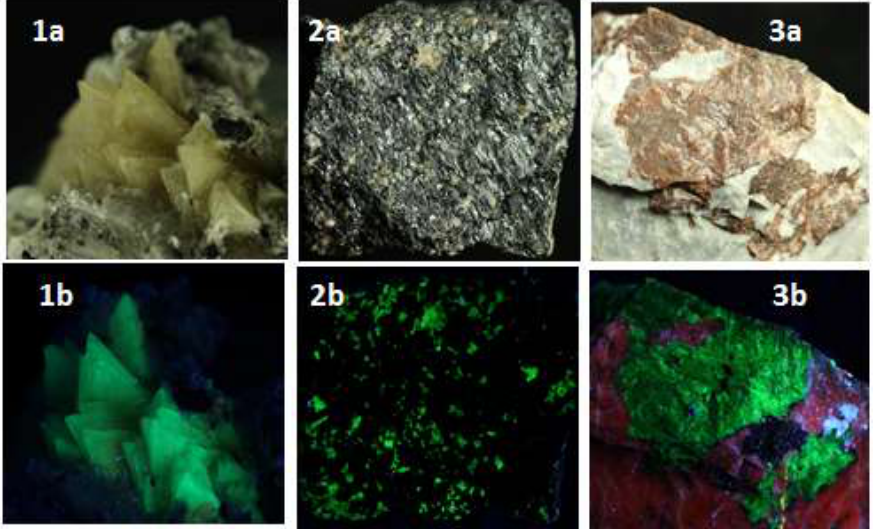
Figure 2. Photos of studied minerals: a—visible light, b—short UV light, 1—genthelvite G1, 2— willemite W2, 3—willemite W1 and calcite.